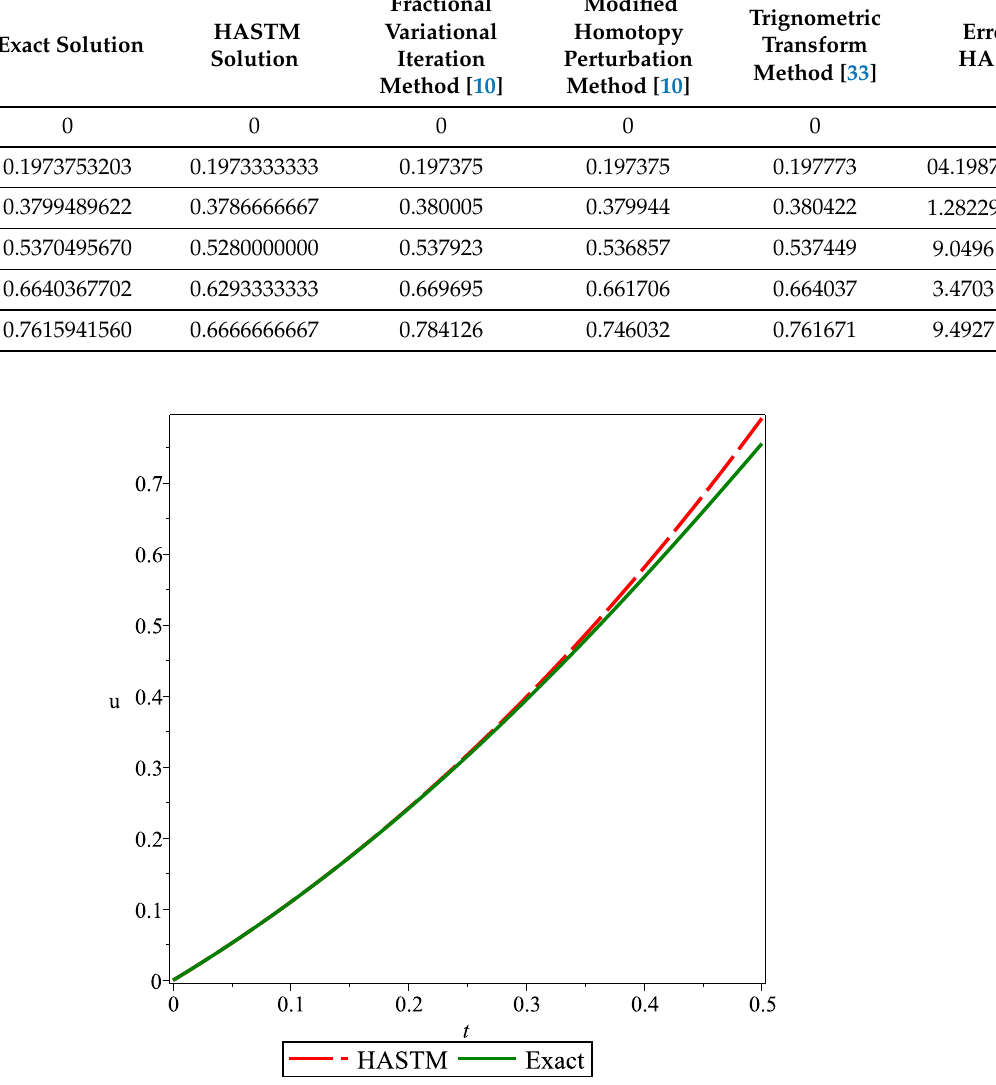
Figure 1. Plot of u ( t ) with respect to t for µ =